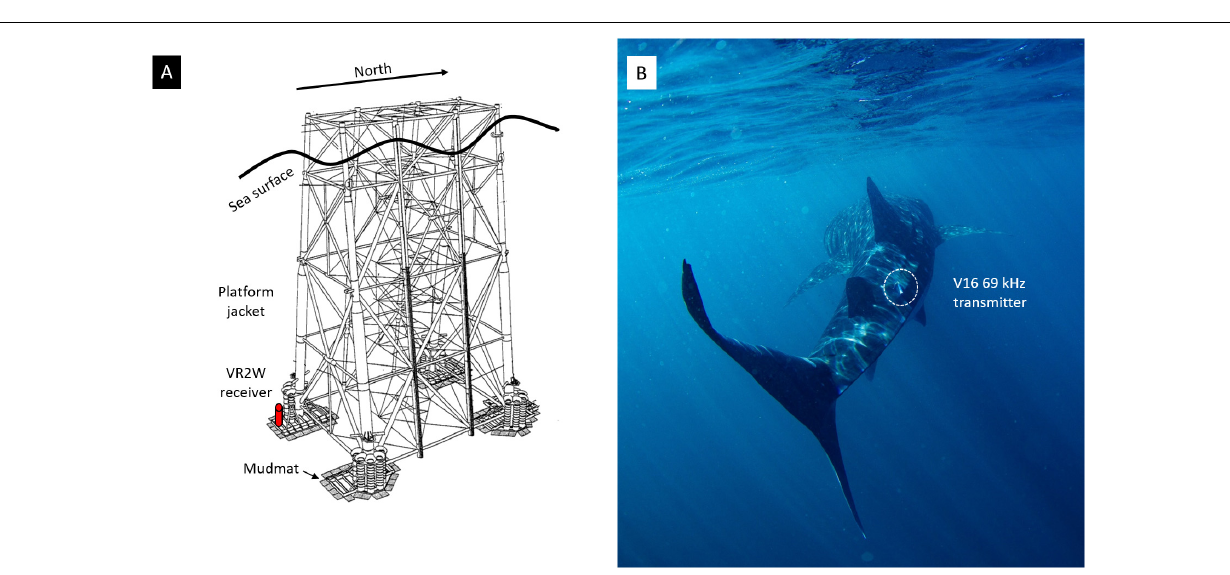
inspection campaign using a platform-tethered ROV. A small weight was attached to the base of the receiver as an anchor and a small float on a line was attached to maintain the receiver in an upright orientation. The receivers were placed at a platform